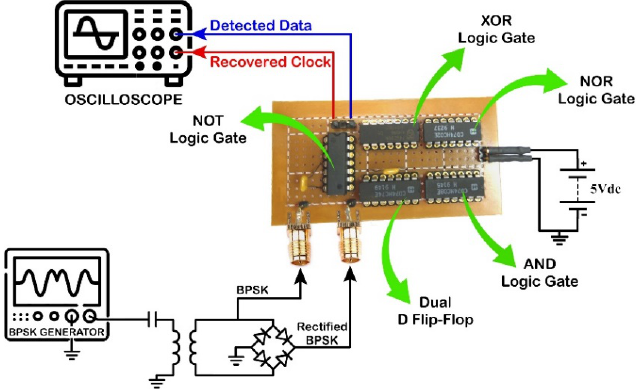
Figure 15. The tested proof-of-concept prototype.